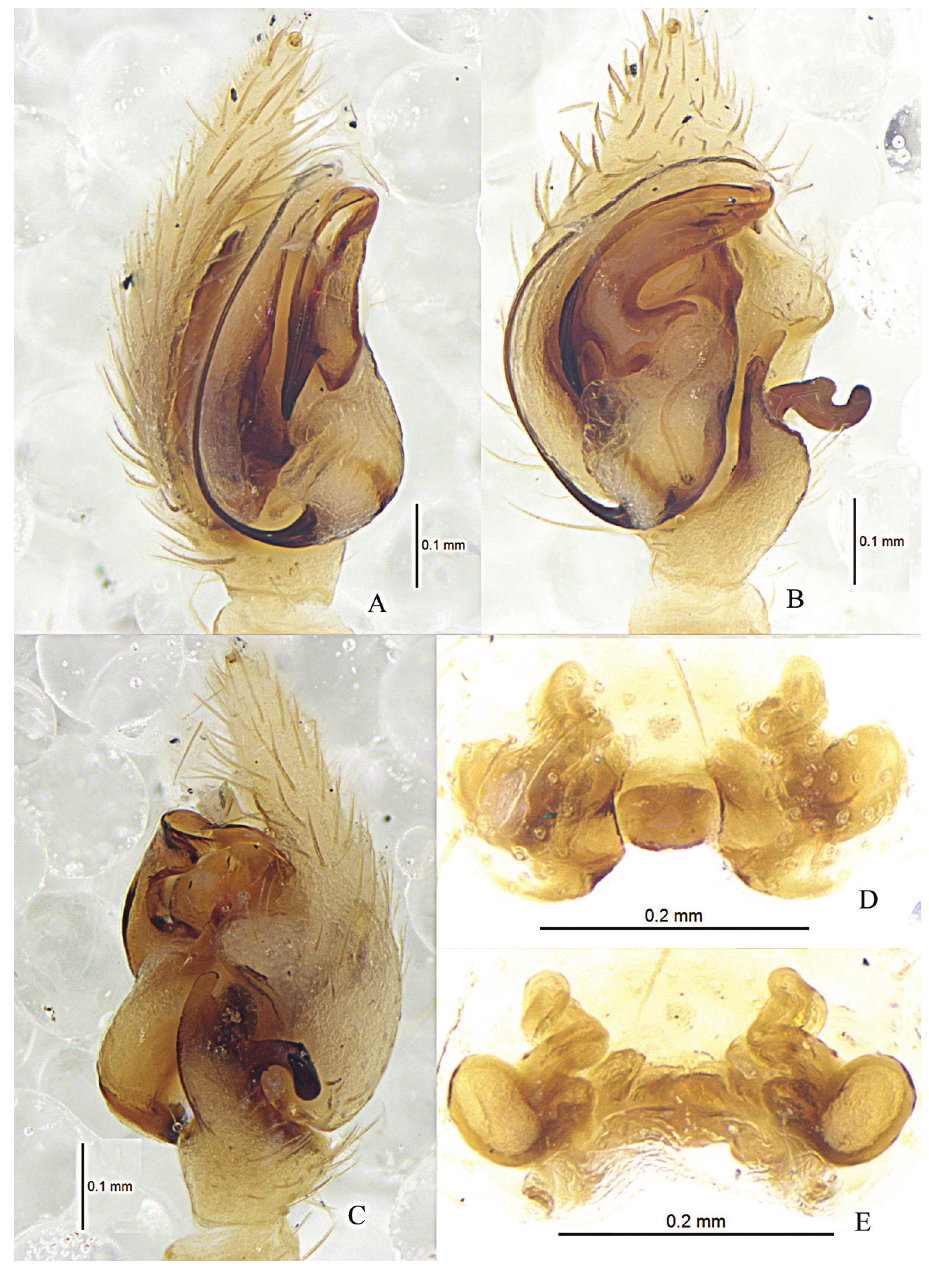
Figure 12. Zodarion furcum Zhu, 1988, male holotype left palp ( A–C ) and female paratype ( D, E ) A Prolateral view B Ventral view C Retrolateral view D Epigynum, ventral view E Vulva, dorsal